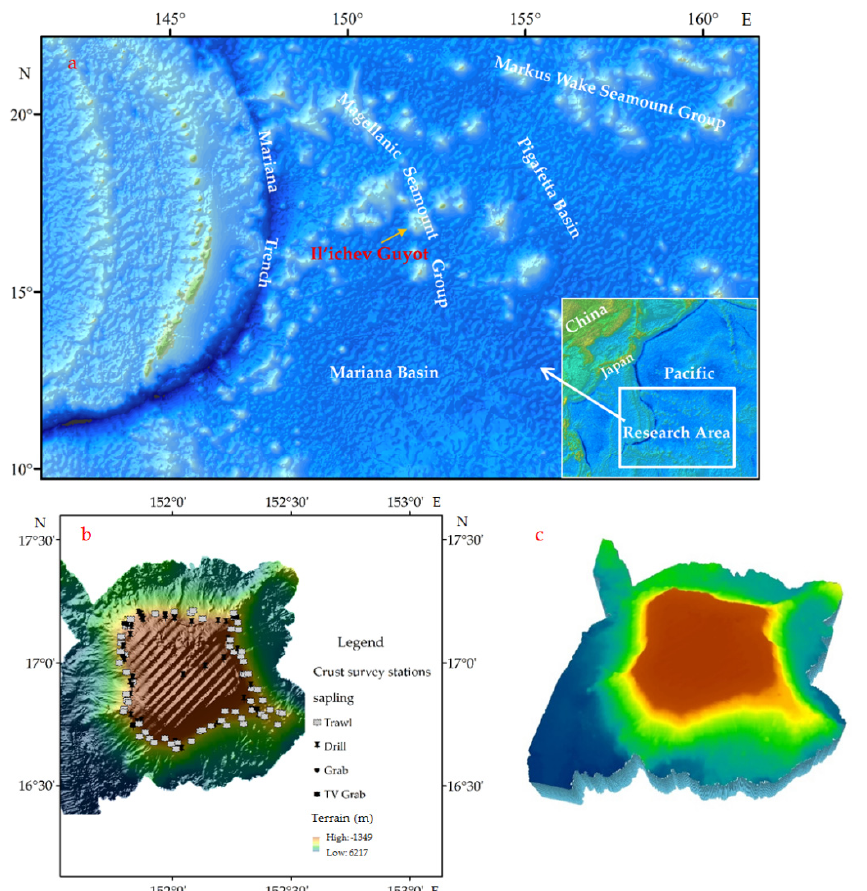
Figure 1. Il’ichev seamount: ( a ) geographical location; ( b ) topography and geological sampling station distribution; ( c ) 3D topographic map.